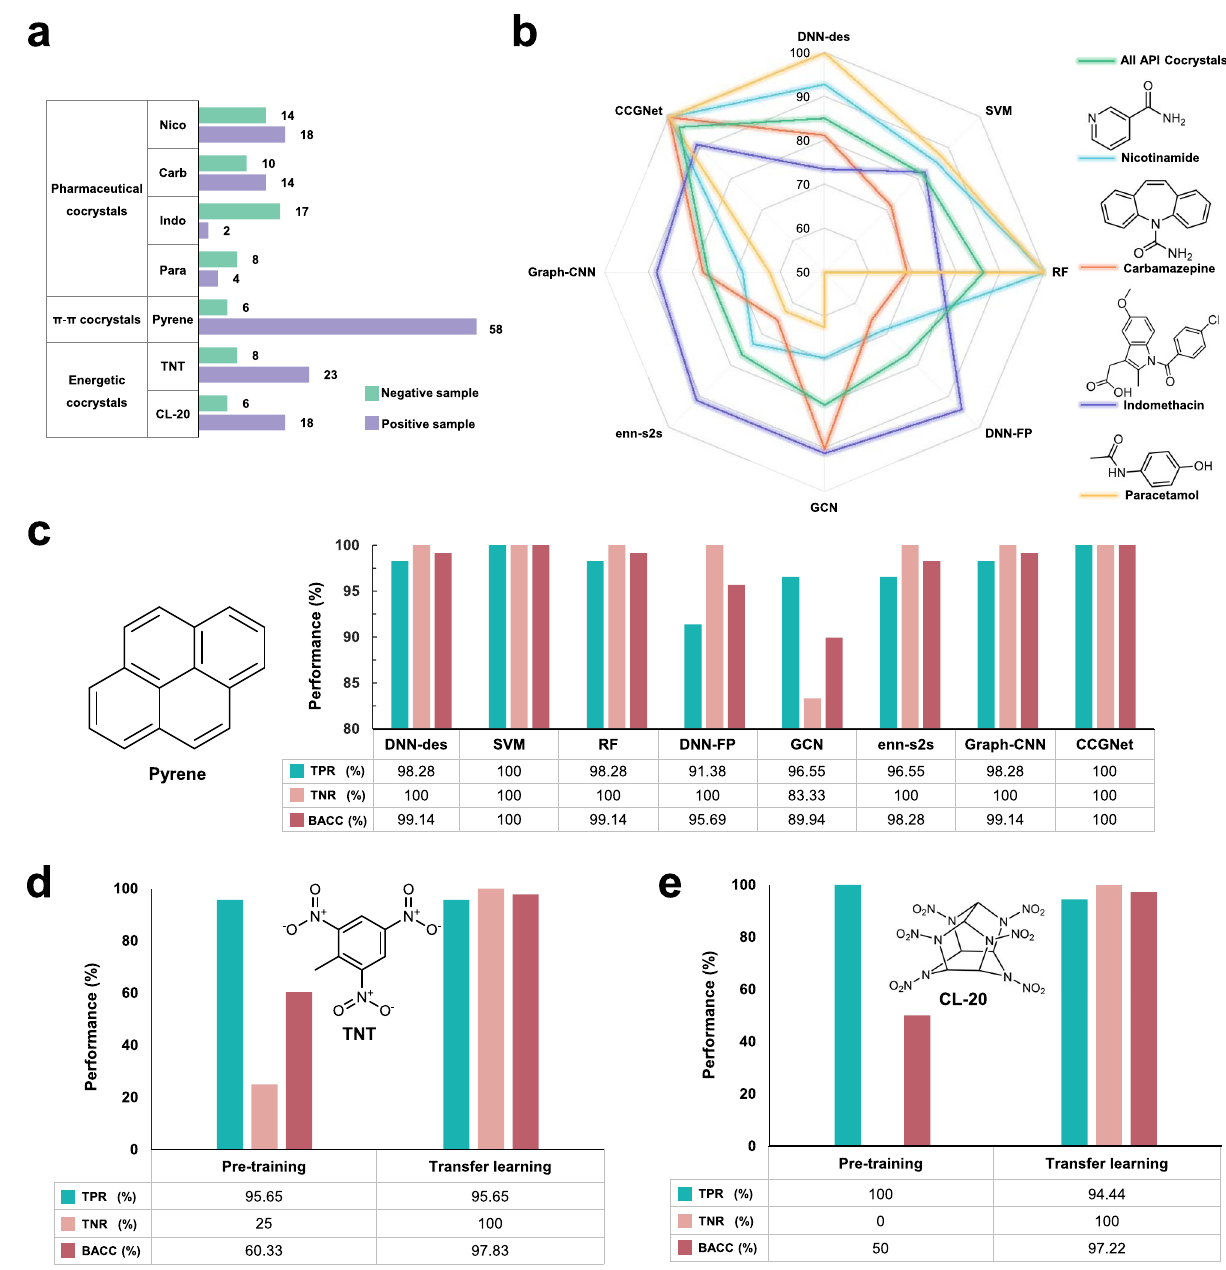
Fig. 3 Model performances on the independent test sets. a Samples of the independent test sets. Nico Nicotinamide, Carb Carbamazepine, Indo Indomethacin, Para Paracetamol. b The balanced accuracy for the four APIs. Cyan Nicotinamide, Orange Carbamazepine, Violet Indomethacin, Yellow Paracetamol, Green holistic performance of all APIs. c The prediction performance on the pyrene cocrystals. TPR, TNR, and BACC denote true positive rate, true negative rate and balanced accuracy, respectively. d The prediction performance on TNT with and without the transfer learning (pretraining). e The prediction performance on CL-20 with and without the transfer learning (pretraining). Green True Positive Rate (TPR), Orange True Negative Rate (TNR), Red Balanced Accuracy